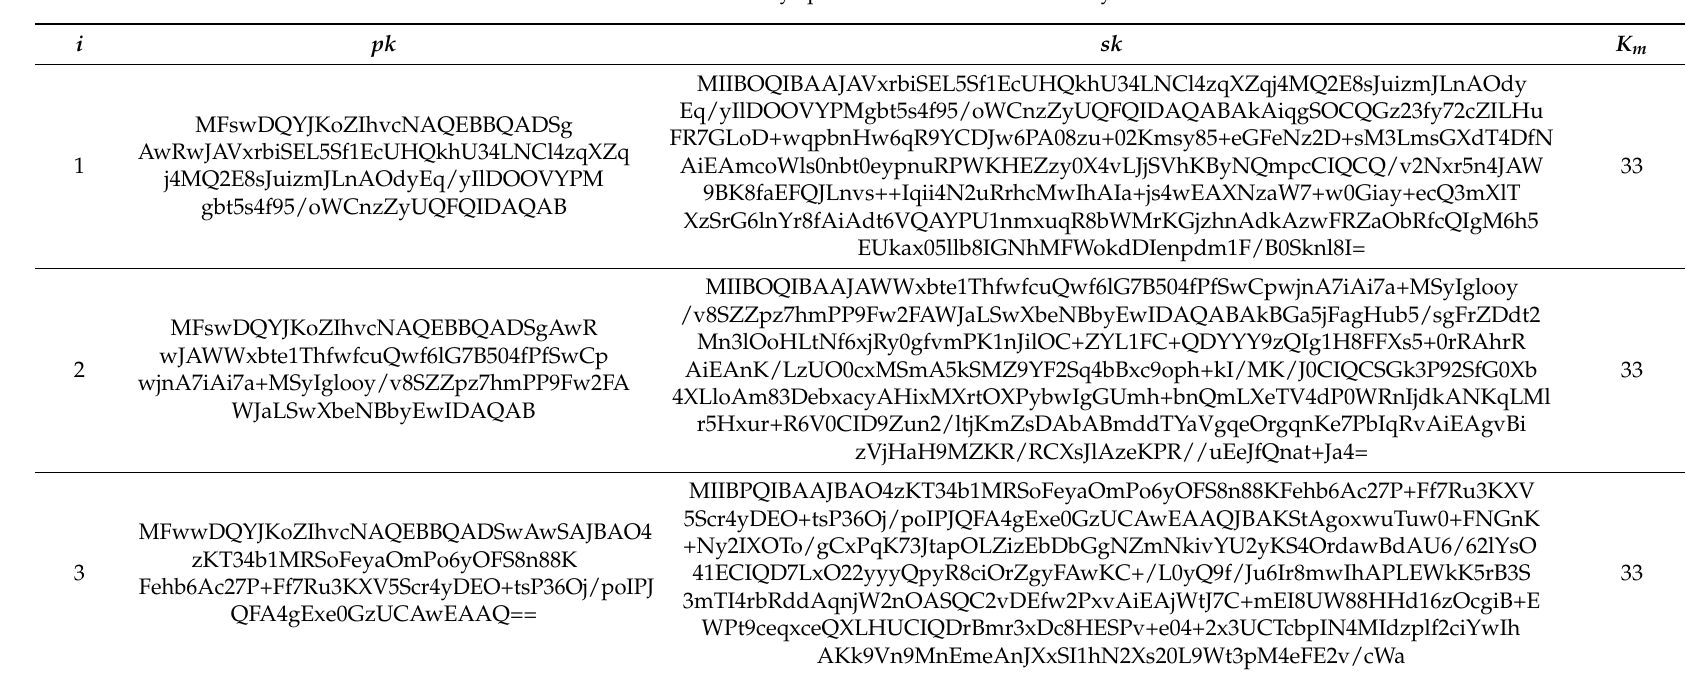
Table A1. RSU keys provided from Trust